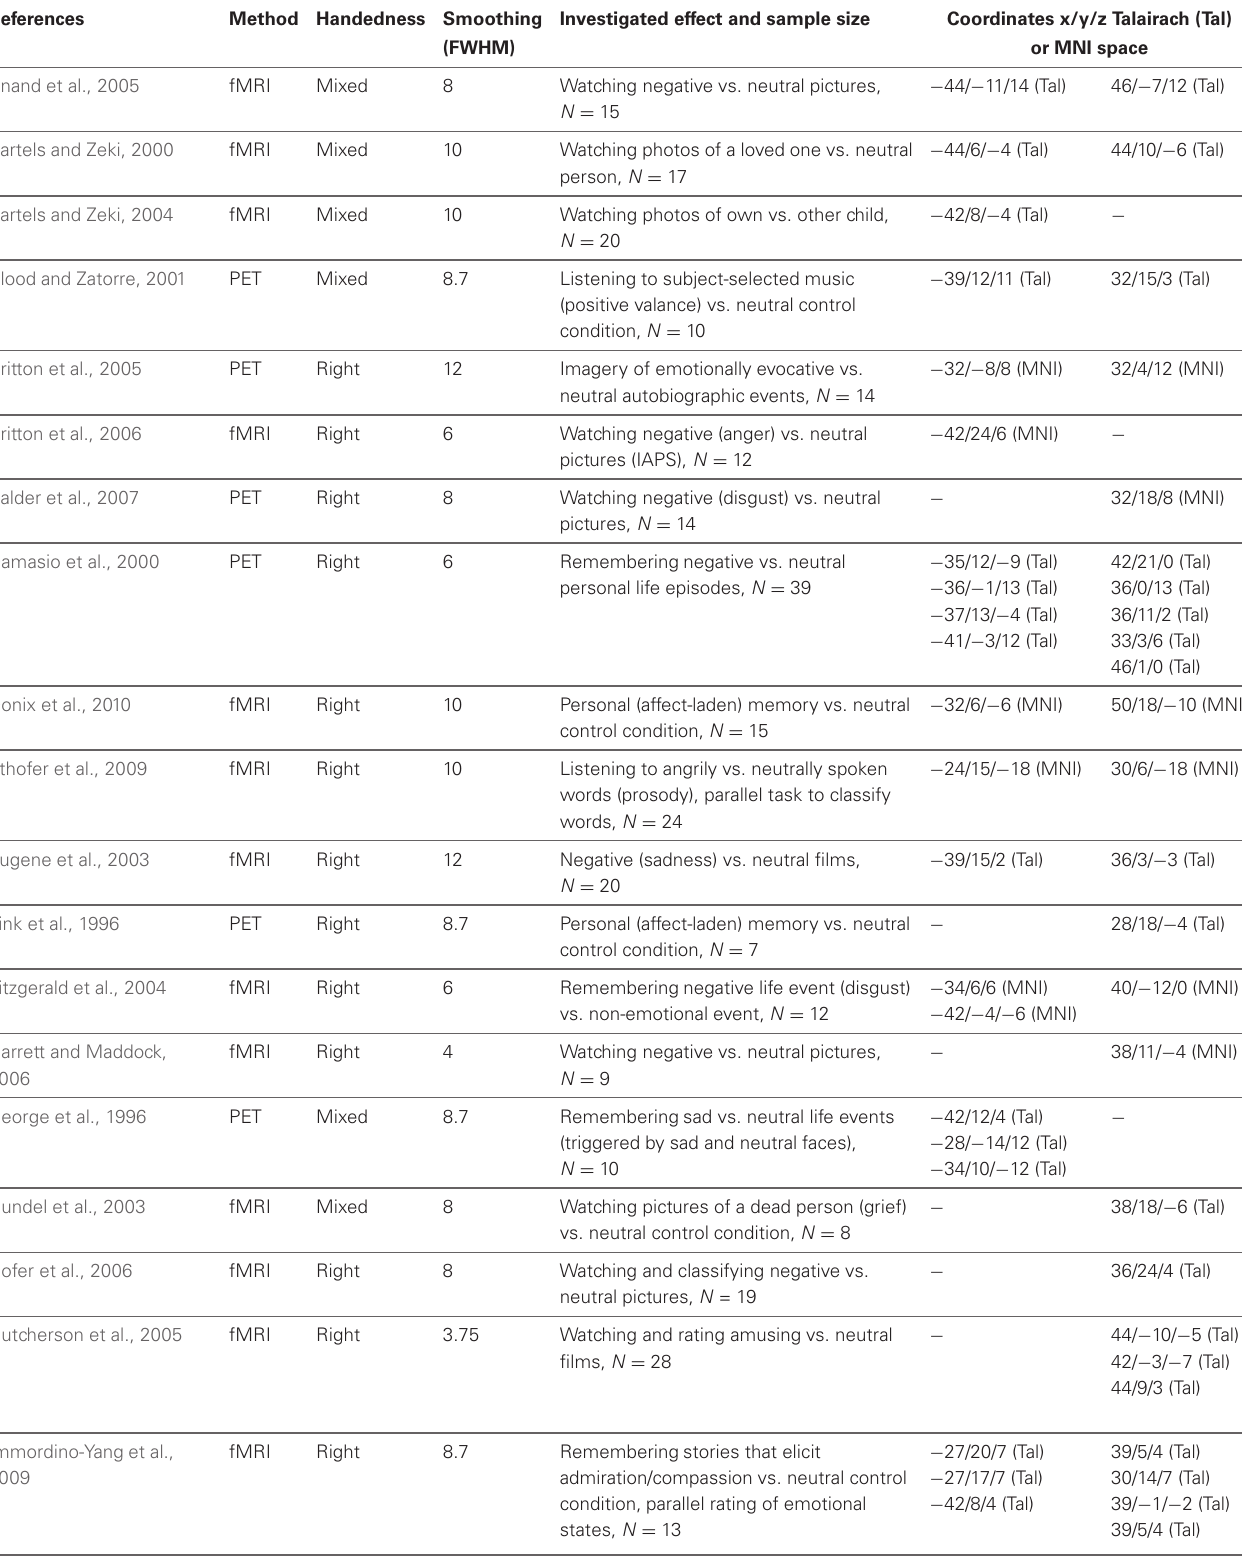
Table C | Fourty-four imaging studies on emotional processing in healthy